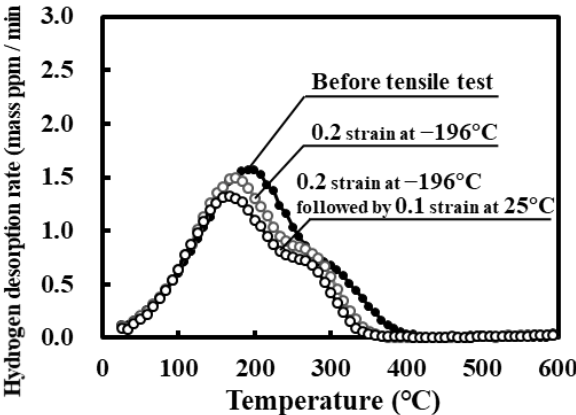
Figure 9. Hydrogen thermal desorption curves for specimens subjected to modified hydrogen charging, tensile straining to 0.2 and unloading at −196 °C followed by tensile straining to 0.1 and unloading at 25 °C. The curve for the specimen before the tensile test is reproduced from Figure 4.